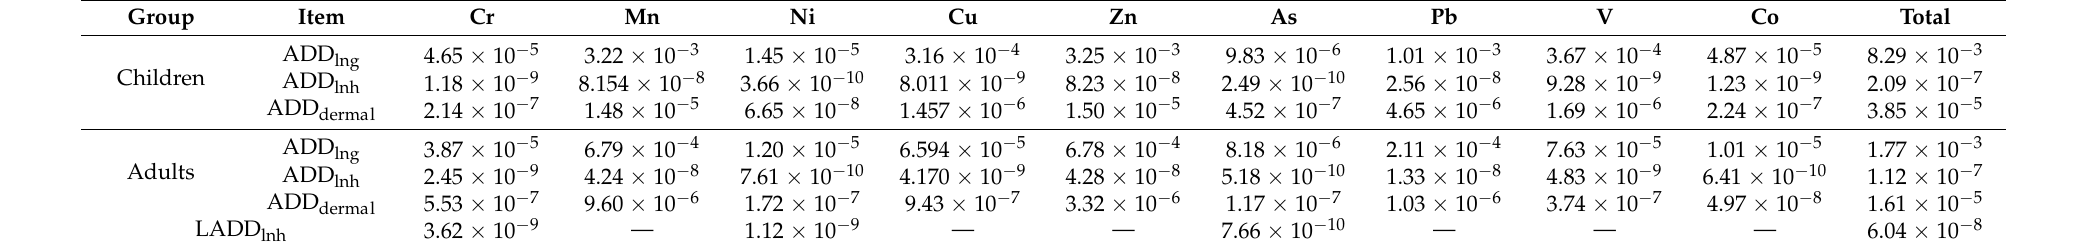
Table 4. Dust heavy metal exposure doses at bus stations in Tianshui City (mg · kg − 1 · d − 1 ).